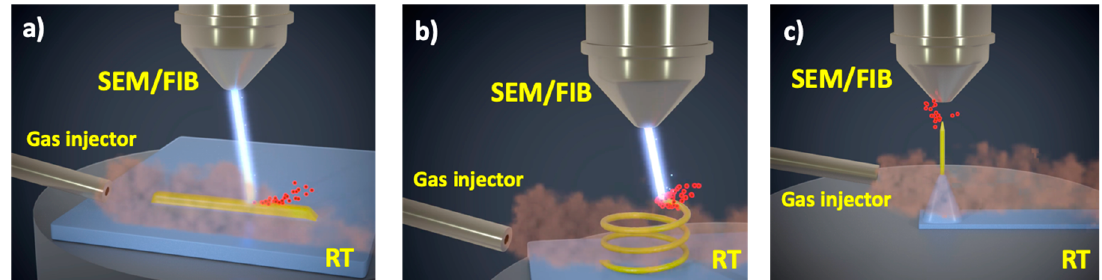
Figure 1. Three different applications of Focused Electron Beam-Induced Deposition (FEBID) and Focused Ion Beam-induced Deposition (FIBID) growth are sketched: ( a ) In-plane nanowires on flat substrates; ( b ) Three-dimensional nanostructures; ( c ) Nanowire growth on tips and cantilevers. RT stands for room temperature.